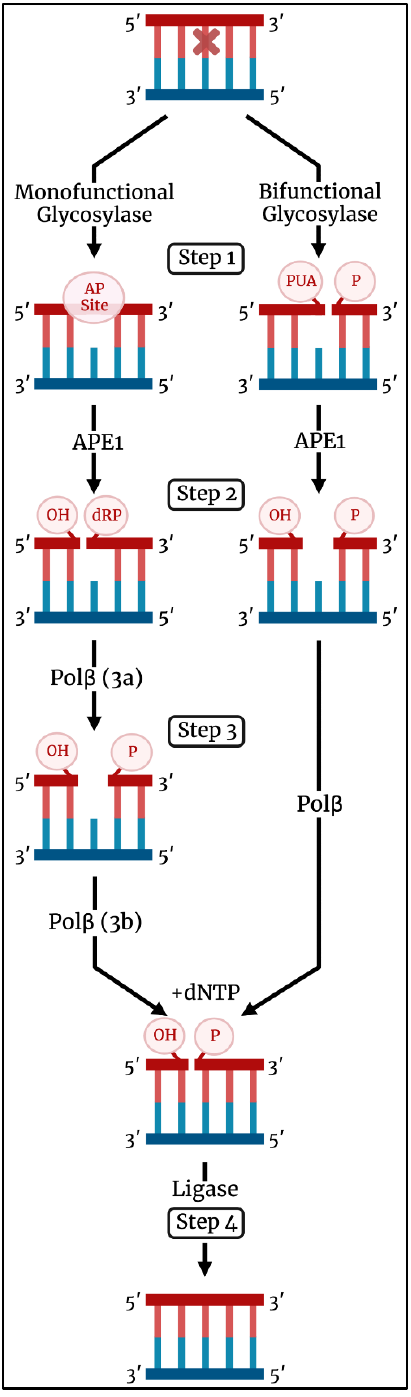
Figure 1. Schematic illustration of the BER pathway initiated by a monofunctional ( left ) and bifunc- tional ( right ) DNA glycosylase. A lesion is recognized and excised by a DNA glycosylase (Step 1). APE1 processes the product of glycosylase activity by incising the AP site (for a monofunctional glycosylase) or removing the 3′ -PUA (for a bifunctional glycosylase) (Step 2). Pol β removes the 5′ - dRP (for a monofunctional glycosylase) and incorporates a canonical nucleotide at the 3′ -OH (Step 3). A DNA ligase/XRCC1 complex seals the nick to complete the repair. Image created using Bio- Render (biorender.com (accessed on 29 September 2022)).